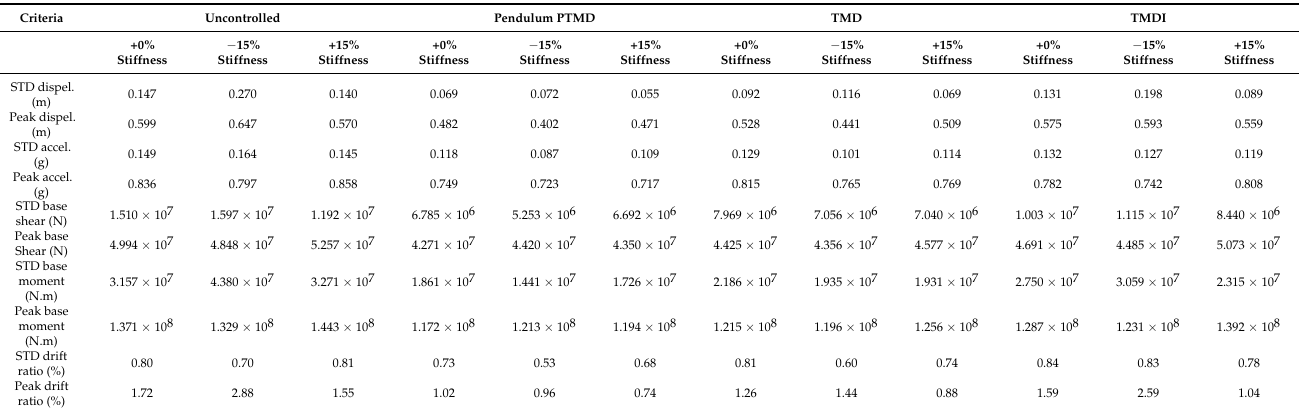
Table 5. The response of the building under El-Centro earthquake ground acceleration with stiffness